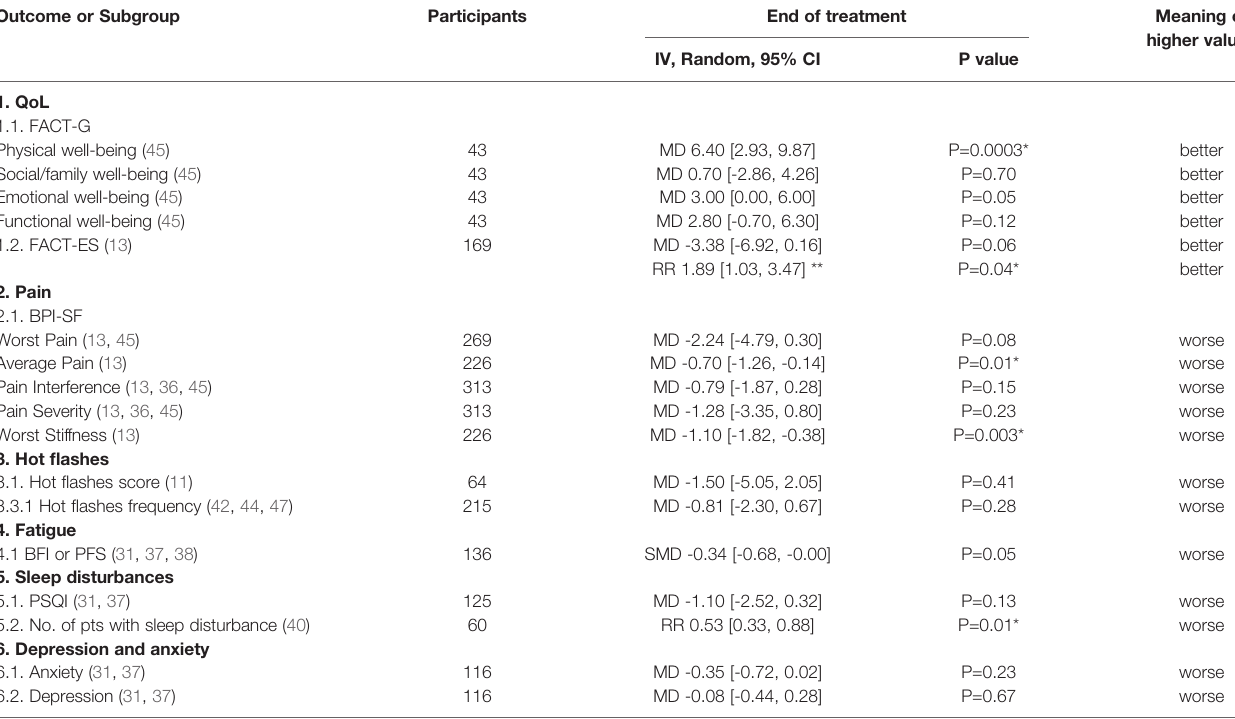
TABLE 4 | The pooled analysis results of high-quality articles for all prede fi ned outcomes. Outcome or